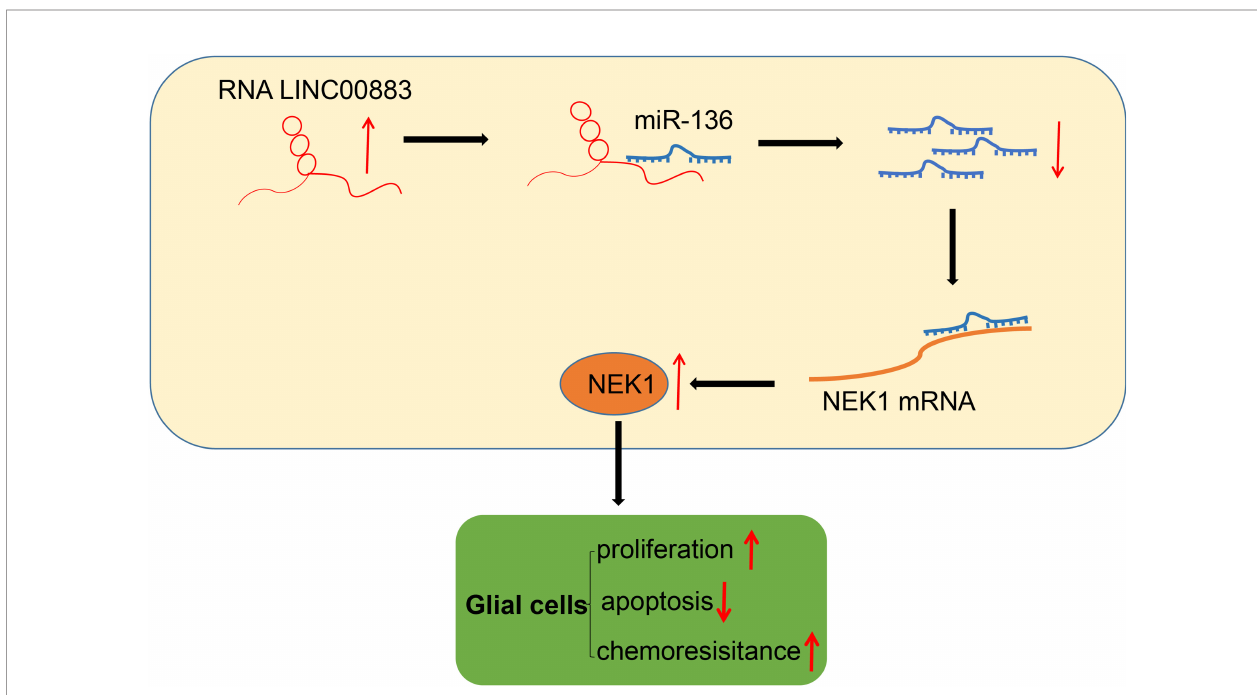
FIGURE 7 | Schematic diagram of the mechanism by which LINC00883 affects the proliferation and drug resistance of glioma cells. LINC00883 competitively binds to miR- 136 and attenuates the binding of miR-136 to NIMA-related kinase 1 (NEK1), thus enhancing glioma cell proliferation and drug resistance but reducing cell